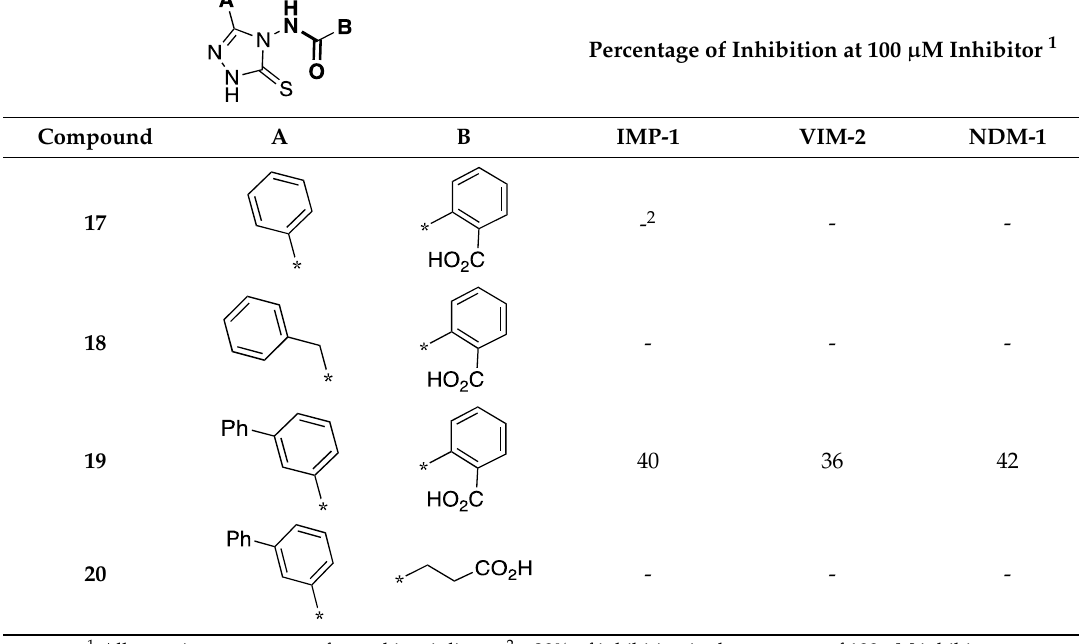
Table 2. Inhibitory potencies of compounds 17 – 20 of the hydrazide-like series against representative MBLs.